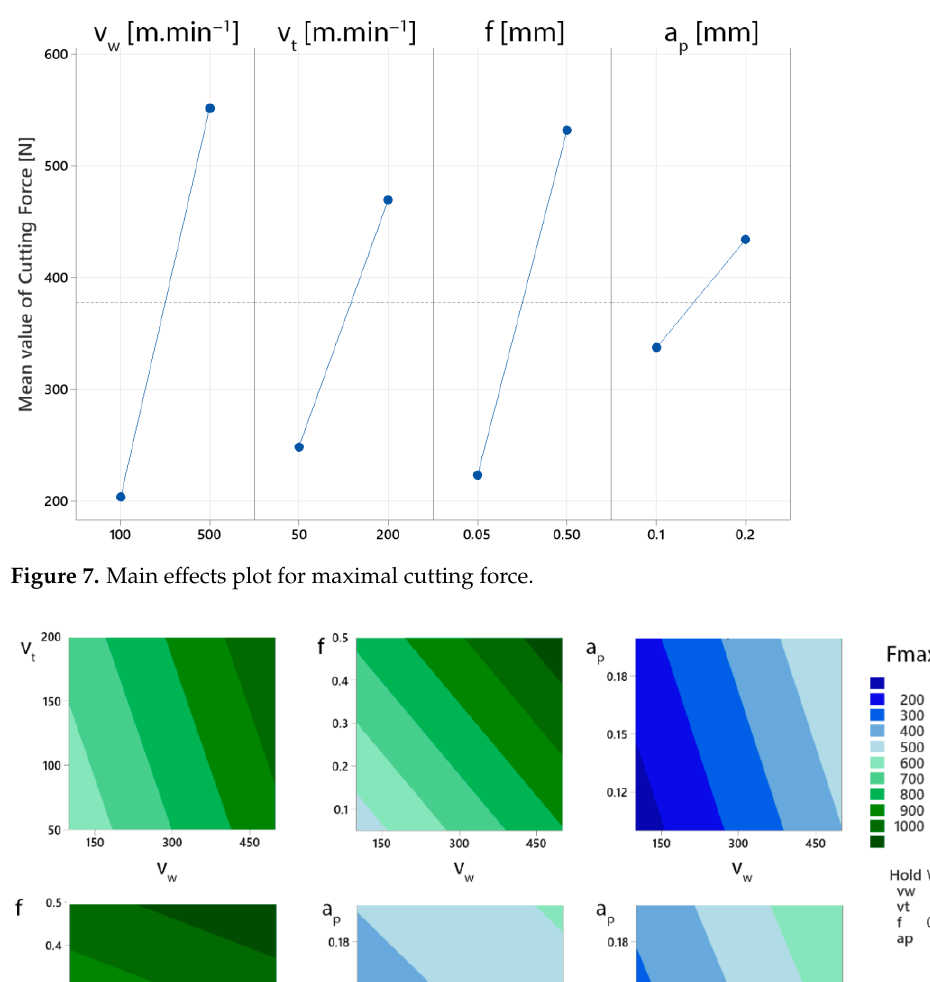
Figure 7. Main effects plot for maximal cutting force.